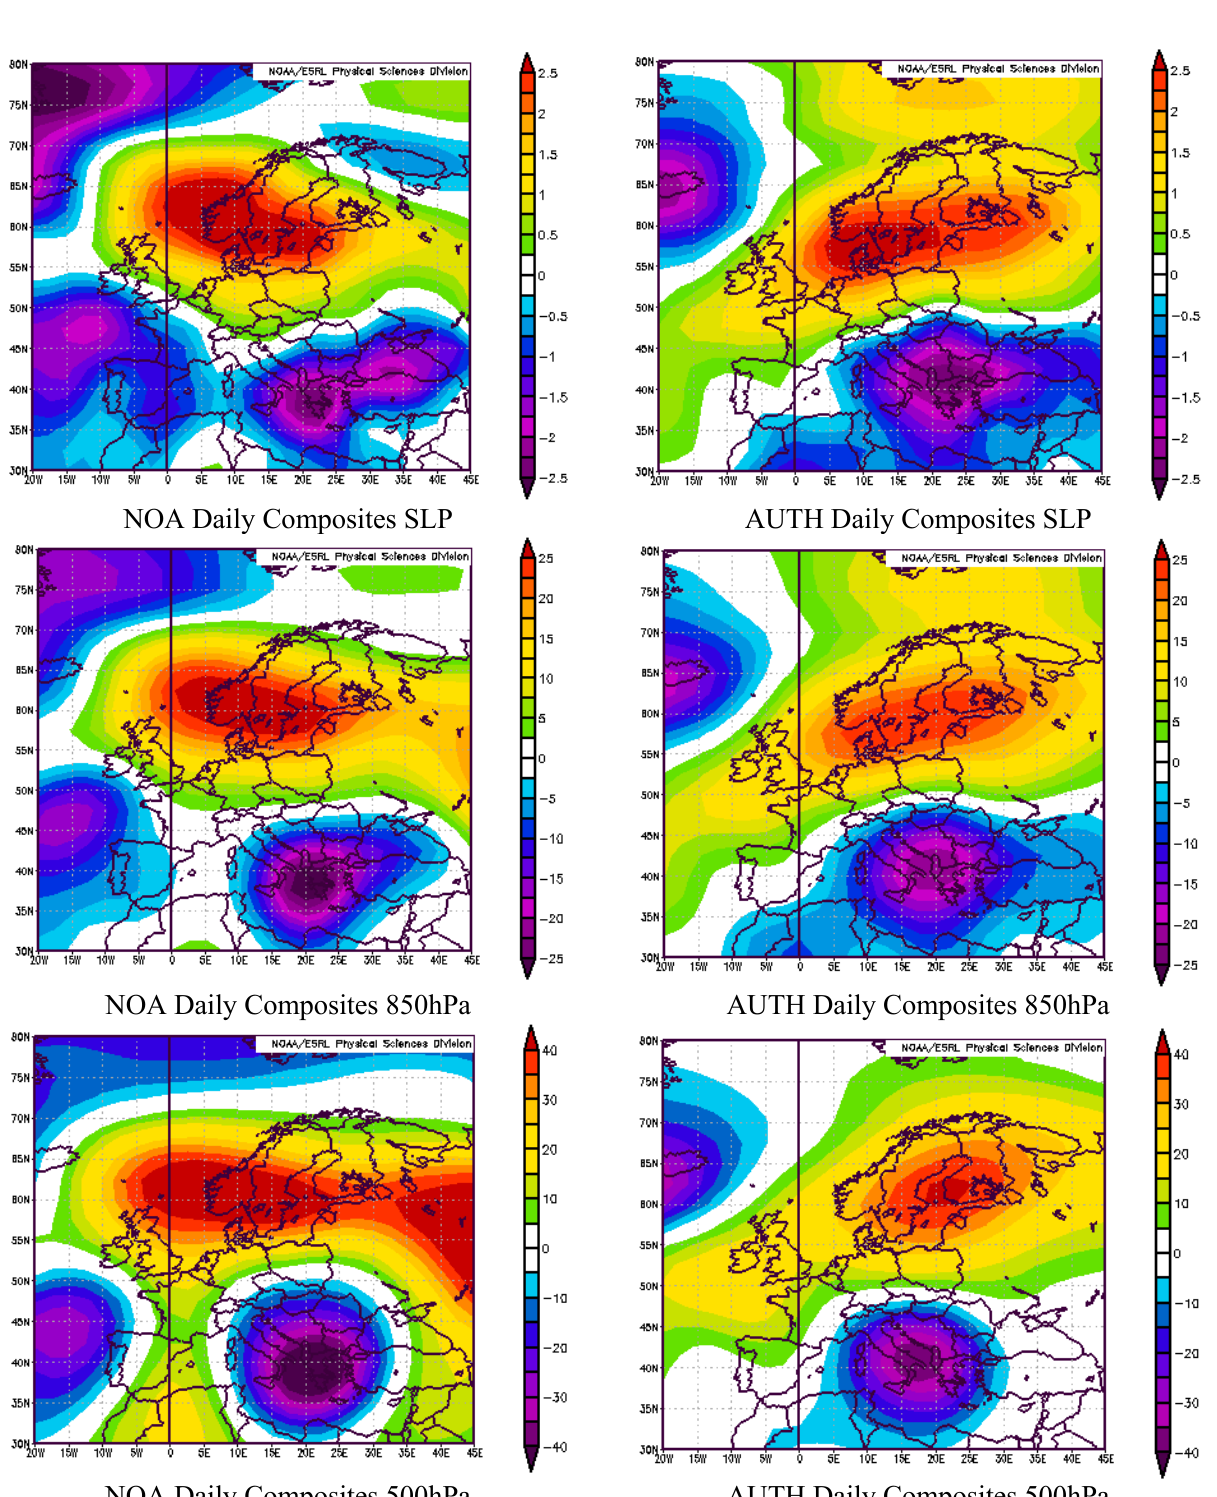
Figure 5. Daily composites of the anomalies (mean - total mean of the period 1968-1996) of the sea level pressure (upper panels), geopotential heights at 850hPa (intermediate panels) and at 500hPa (lower panels) from the NCEP/NCAR Reanalysis. The daily composites concern days with extreme rain intensity greater than the upper 1st percentile (99%) during the warm period of the year (29 days for Athens and 47 days for Thessaloniki).